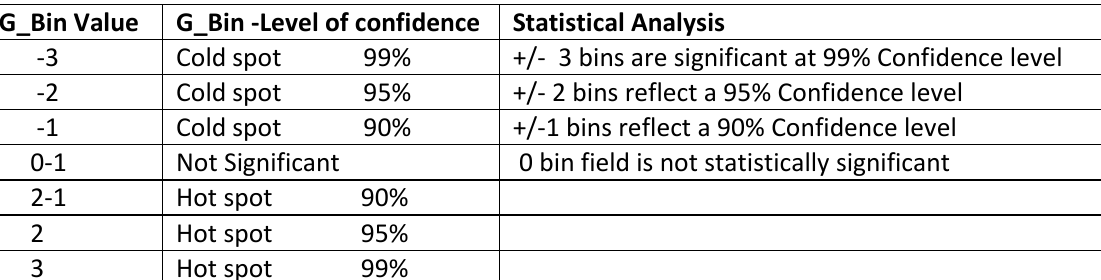
Table 4.0 Statistical Analysis of hotspot map using